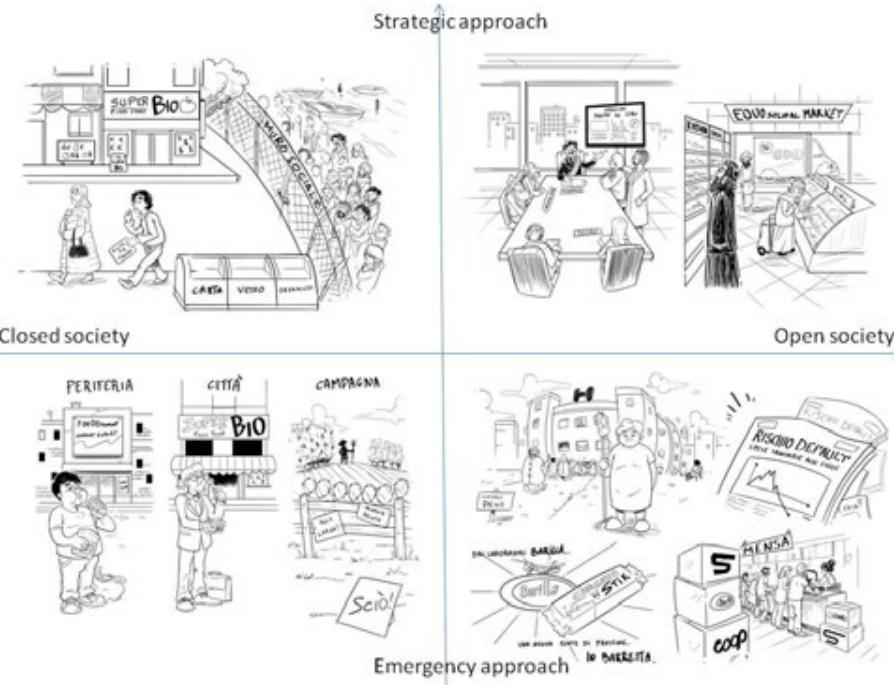
Figure 3. Local downscaled scenarios based on i) way of intervention by the government and ii) atti- tude of society towards societal